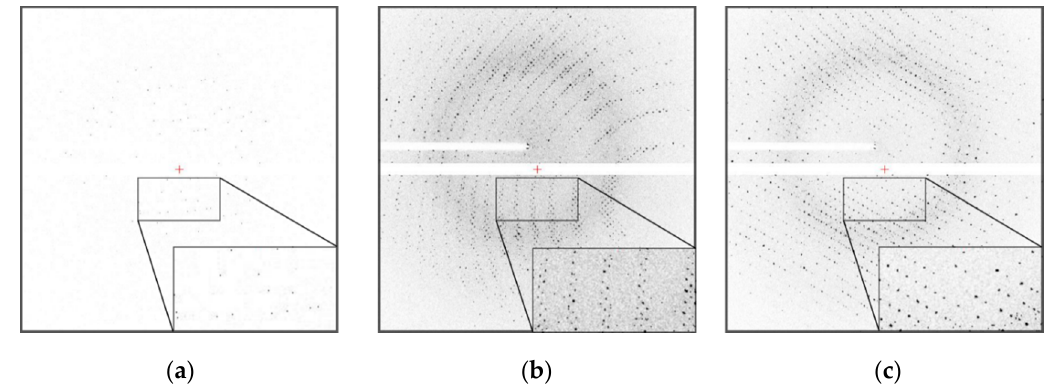
Figure 4. Examples of diffraction images acquired at ( a ) the lowest flux of ~10 8 photons/sec (dataset L21_001), ( b ) at 1 kHz frame rate with 50% of the incident photon flux ~9 × 10 10 photons/sec (dataset L11_50), and ( c ) at 3 kHz frame rate with 50% of the incident photon flux ~9 × 10 10 photons/sec (dataset L13_50) (summation of 30 images for each subpanel).